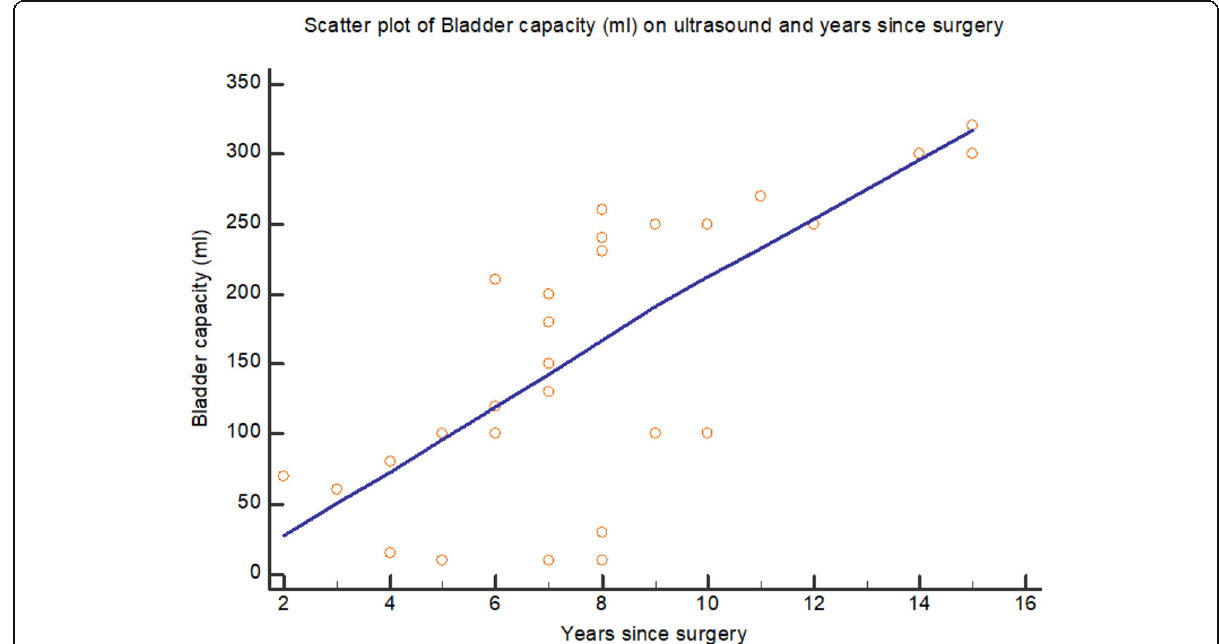
Fig. 6 Graph depicting correlation of bladder capacity with time since surgery